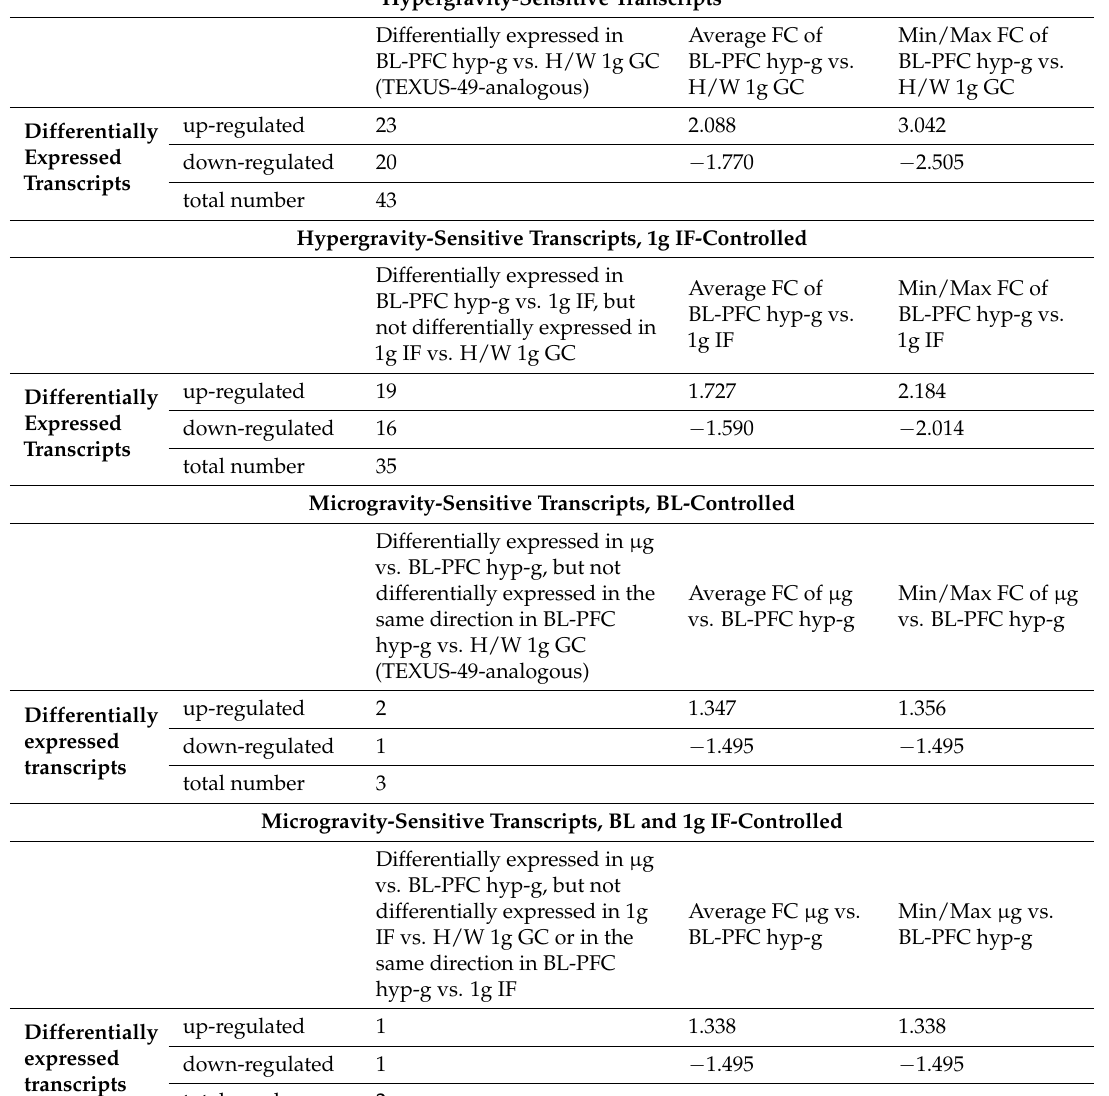
(Table 4). In the investigation of hypergravity and microgravity double-sensitive transcripts